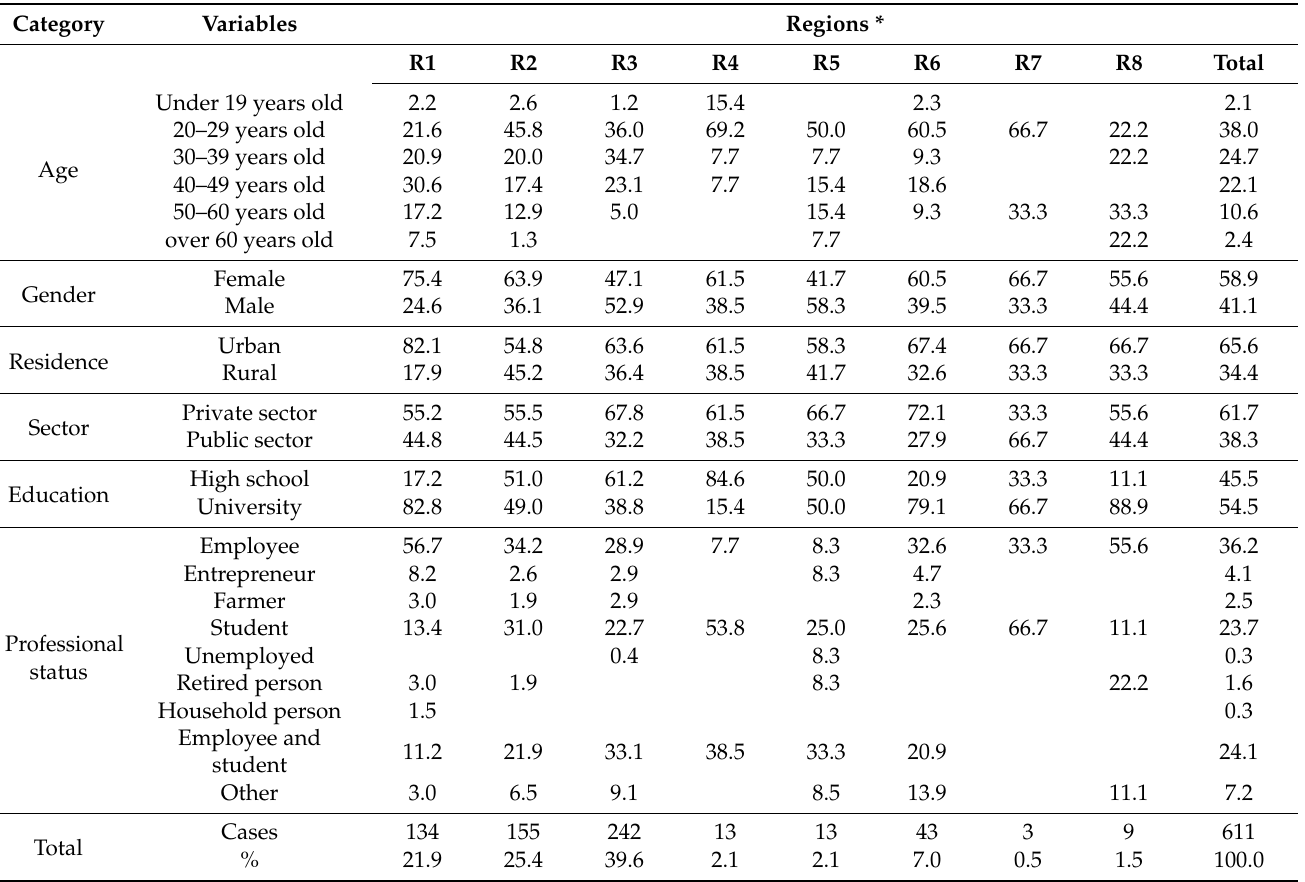
Table 2. Frequencies within the individual characteristics among the eight regions in Romania